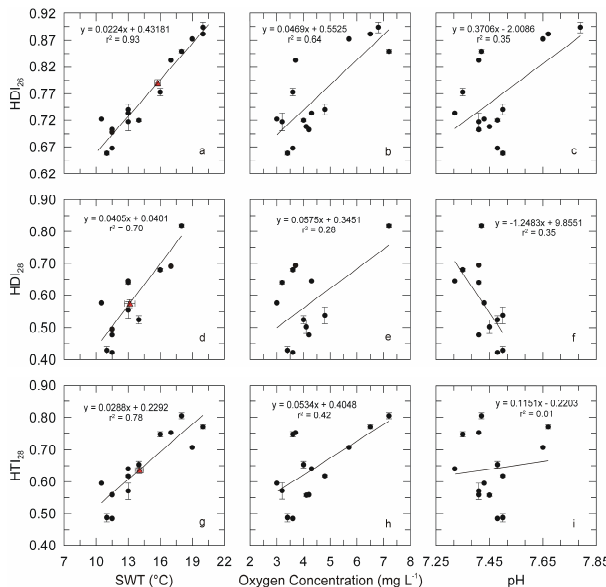
Figure 4. Cross-plots of the HDI 26 (a–c) , HDI 28 (d–f) and HTI 28 (g–i) obtained from water column filtrates with measured SWT, oxygen concentration and pH of Lake Schreventeich’s sur- face waters. Red triangles represent HDI 26 -, HDI 28 - and HTI 28 - reconstructed SWTs obtained from the analysis of surface sedi- ments of Lake